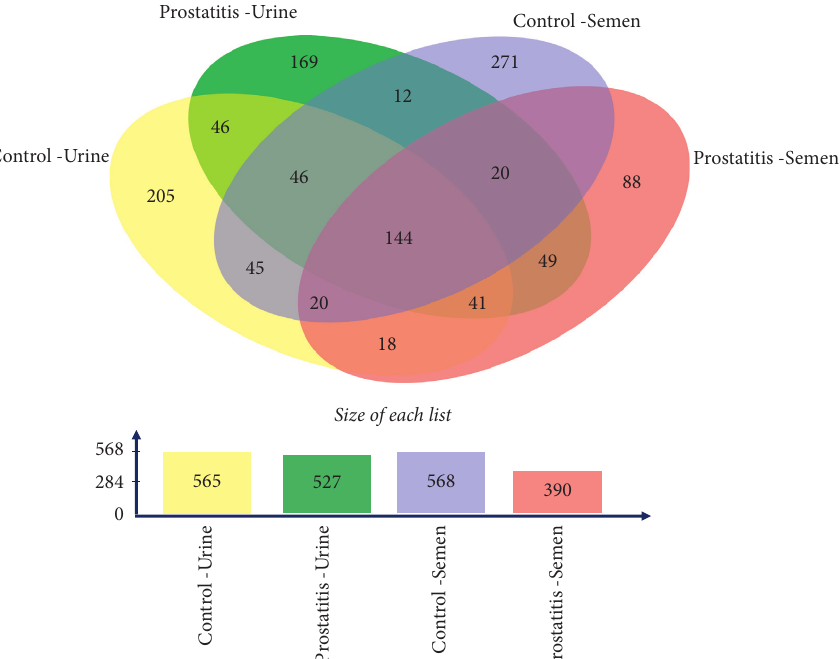
Figure 1: Venn diagram of OTU overlapping in urine and semen samples. (a) Venn diagram obtained with semen and urine samples from chronic prostatitis symptoms and fertile men showing that both types of samples in both groups share 144 OTUs. (b) Semen and urine samples from volunteers with chronic prostatitis showing a lower amount of OTU than samples from fertile men in the control